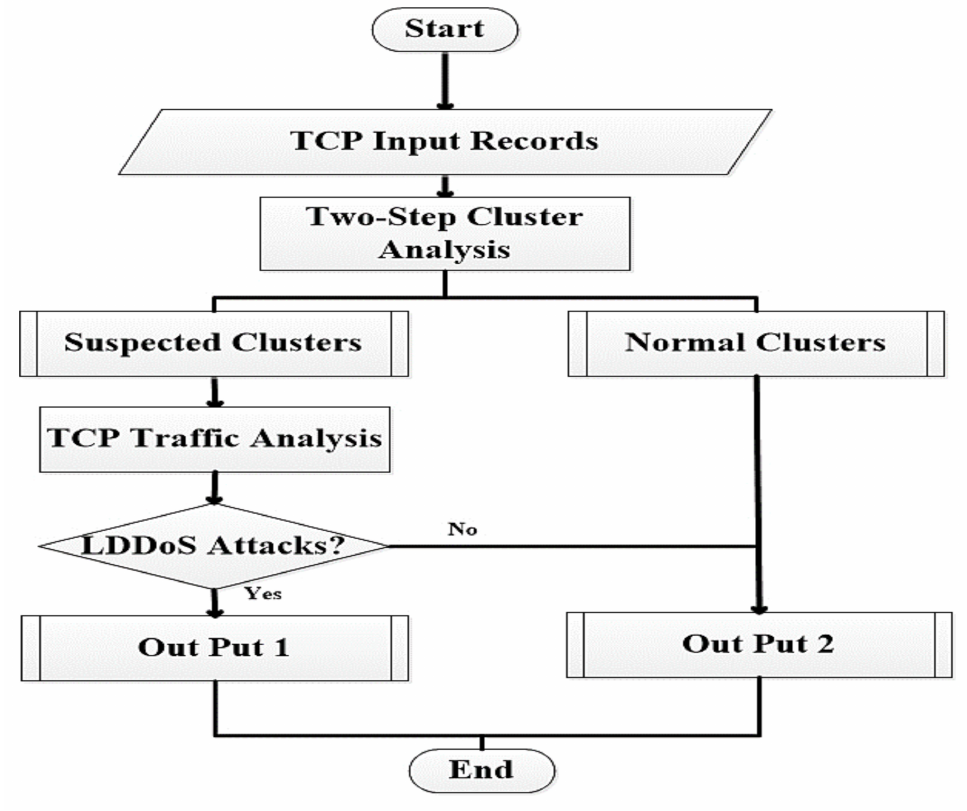
Figure 4. Flow process diagram of LDDoS